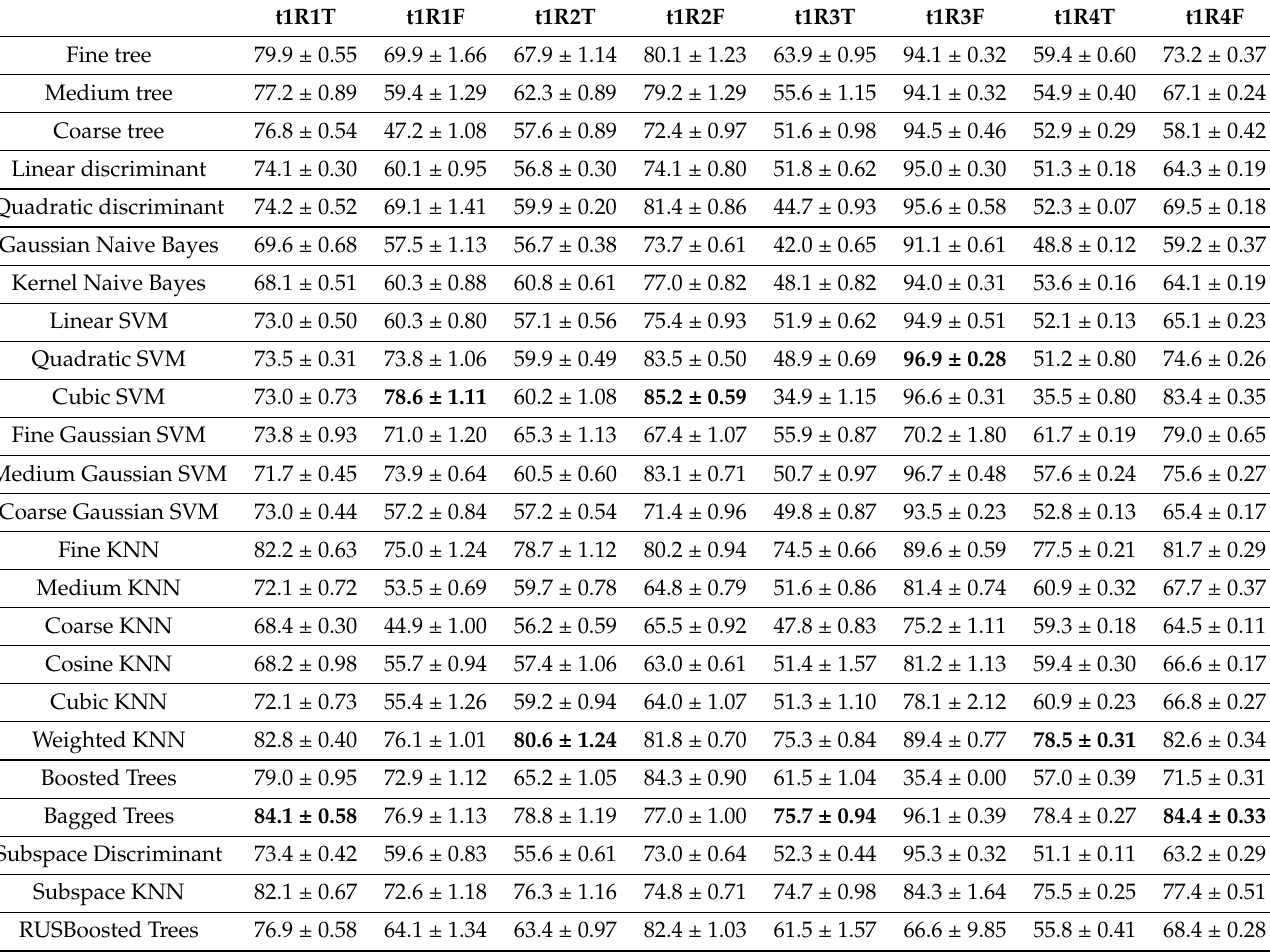
Table 2. Resulting success rate of classification of individual methods for experiments with sample time t1 (0.25 s). The best results are marked in